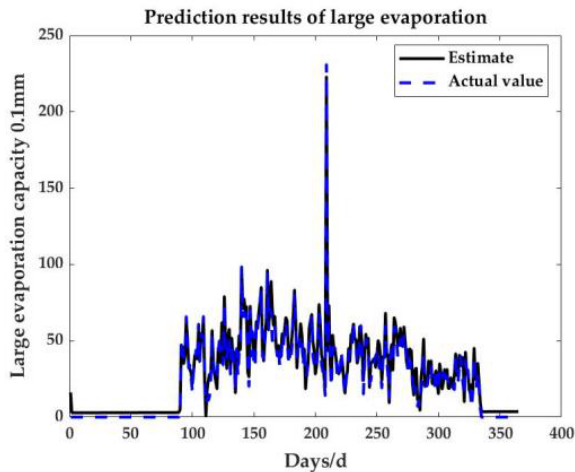
Figure 10. Graph of anticipated results.